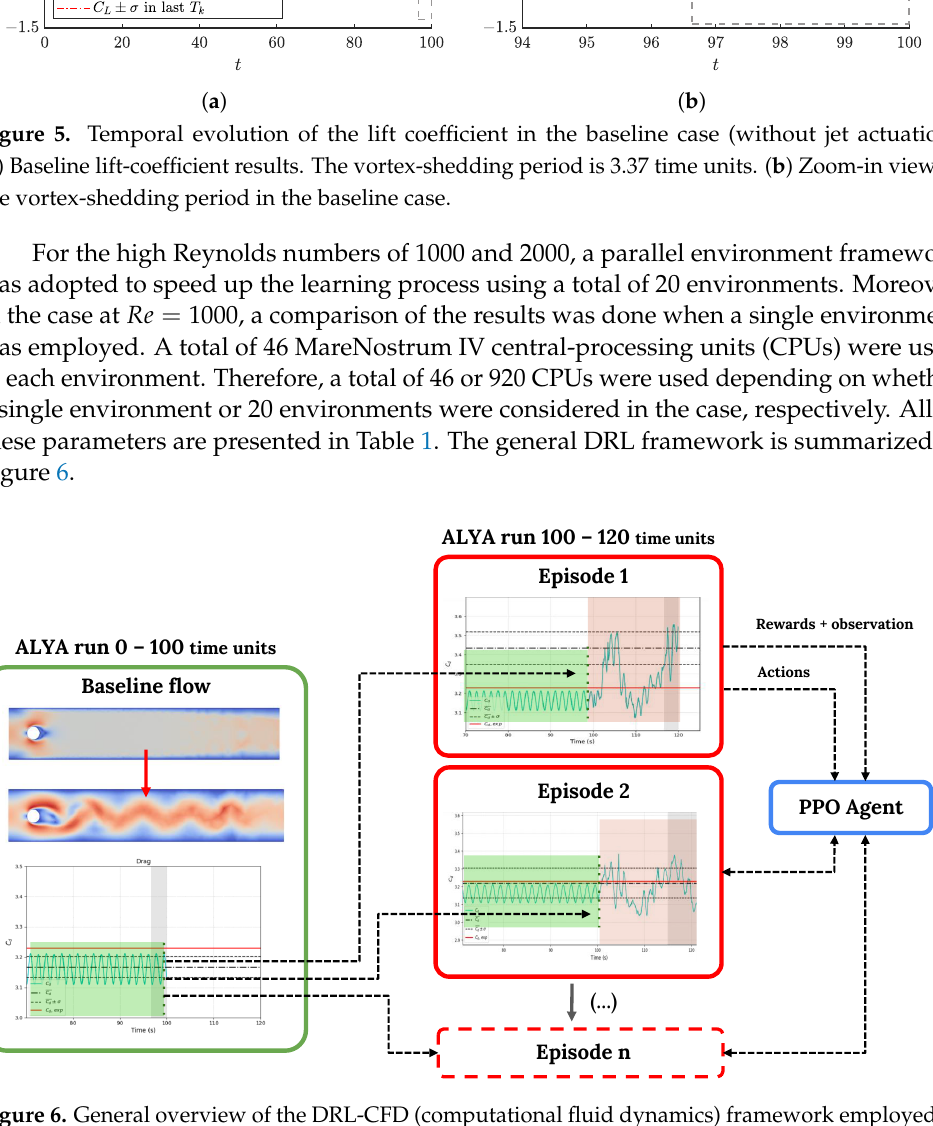
Figure 6. General overview of the DRL-CFD (computational fluid dynamics) framework employed in this work. A multi-environment approach was used to parallelize the learning and speed up